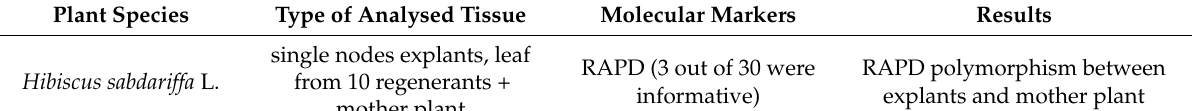
Table 2. Identification of somaclonal variations by DNA